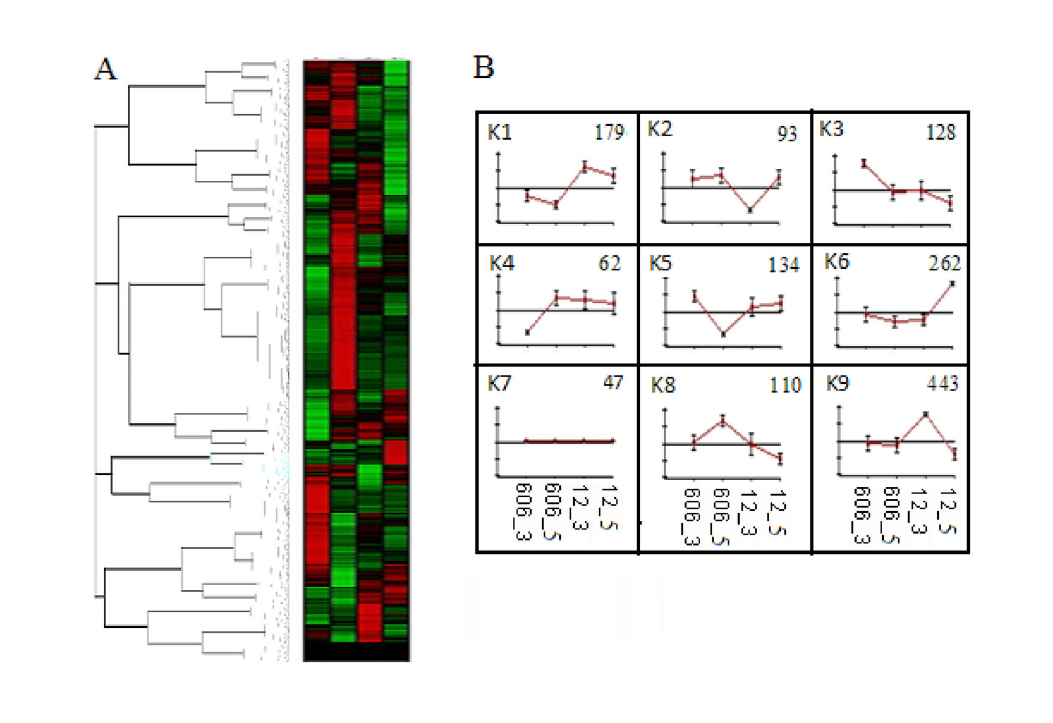
Figure 5. K-means clustering (A) the expression profile (B) of the Unigenes involved in lipid metabolism. The nine clusters are presented in B (K1 - K9). The error bars represent the standard